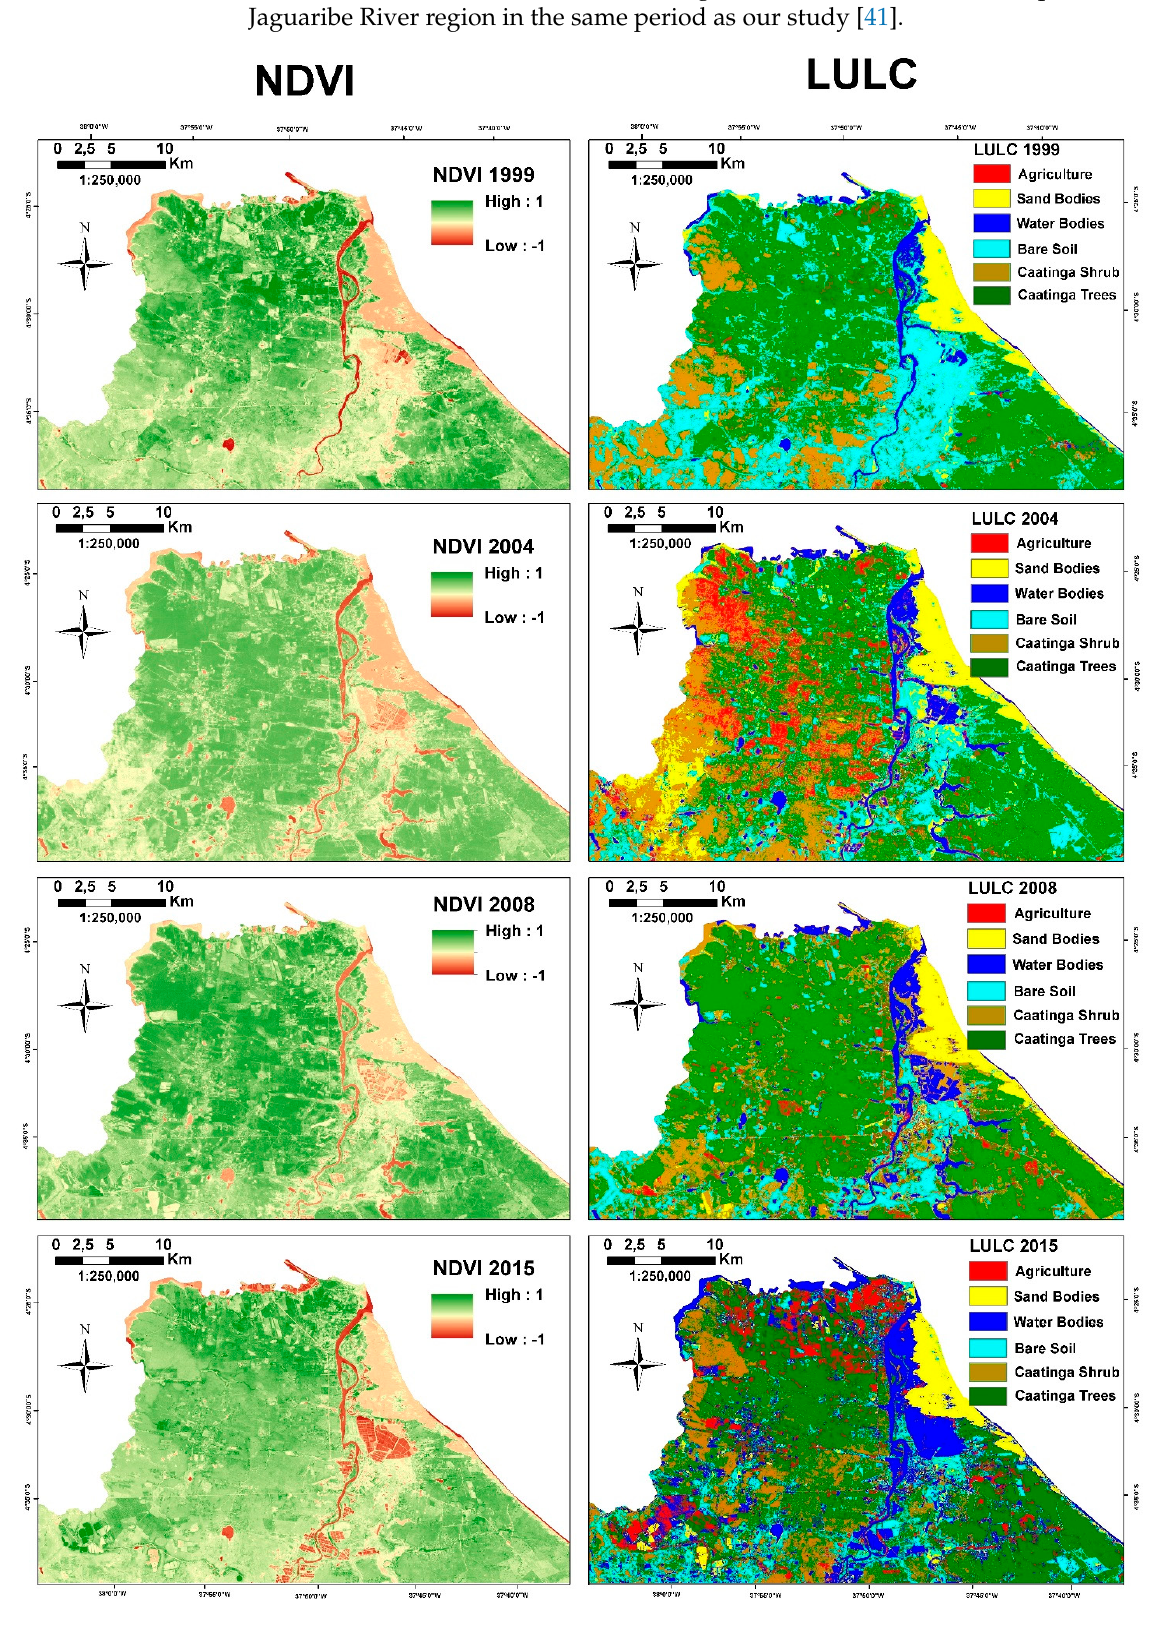
Figure 4. Land use and land cover and NDVI in the LJRSB coast for 1999, 2004, 2008, and 2015.